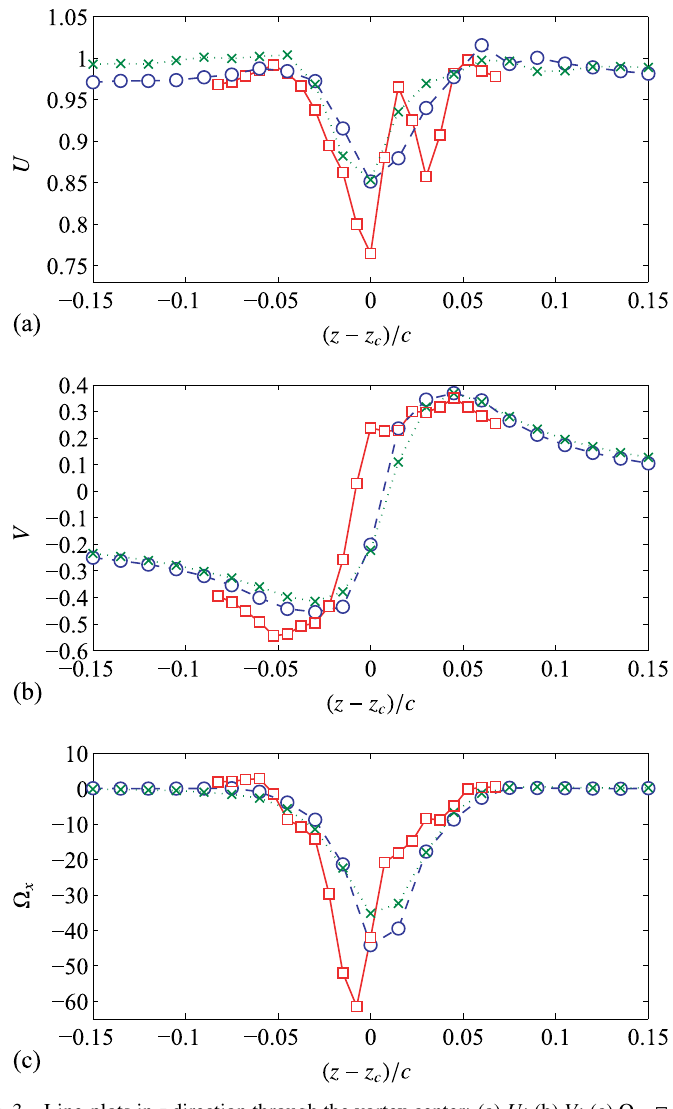
Fig. 3 Line-plots in z direction through the vortex center: (a) U ; (b) V ; (c) Ω x . (cid:2) , x / c = 0.01; ◦ , x / c = 0.5; × , x / c =